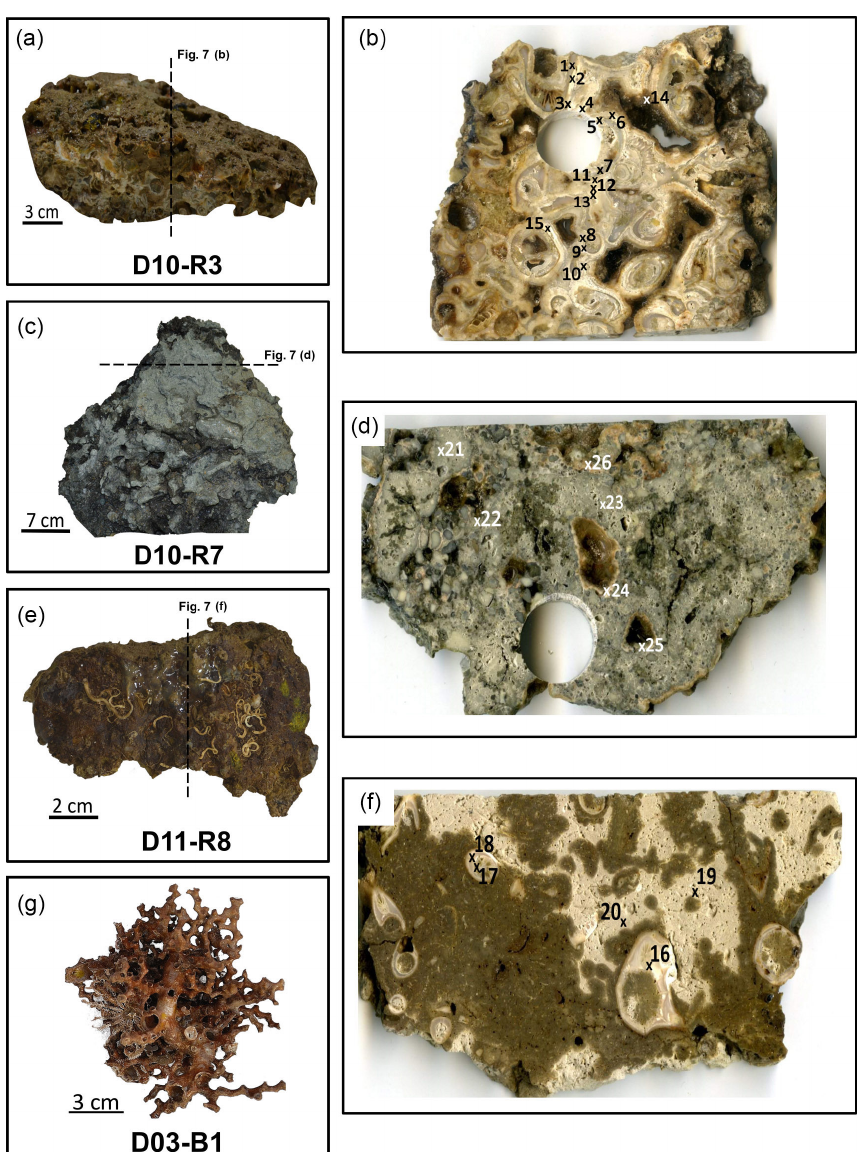
Figure 7. Photographs of analyzed samples including sampling sites for stable carbon and oxygen isotope ( δ 13 C, δ 18 O) analysis (crosses with numbers). Values of the stable isotopic analyses are found in Table 2. (a–b) D10-R3 carbonate with embedded corals (c–d) D10-R7